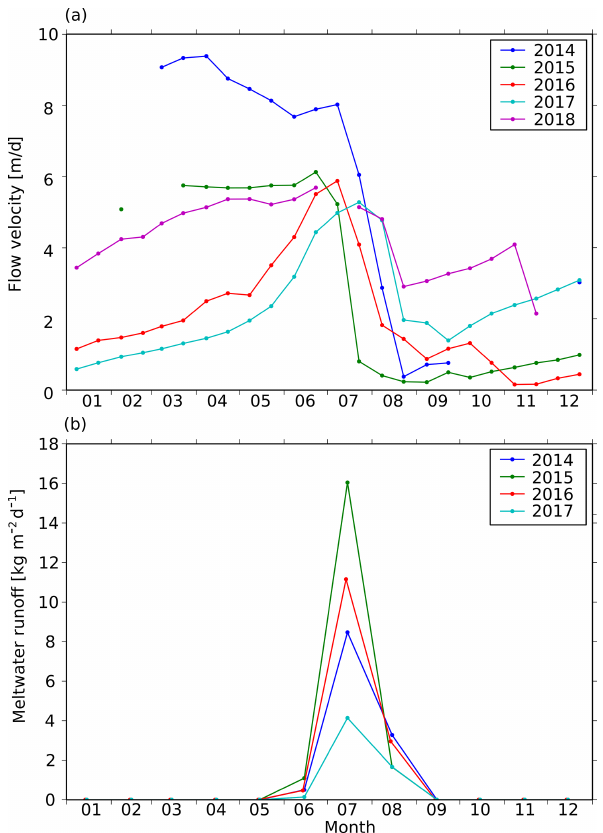
Figure 8. Seasonality of flow velocities (semi-monthly velocities at the point marked by the black triangle in Fig. 1) (a) and meltwater runoff (b) . For 2018, data of meltwater runoff were not available.